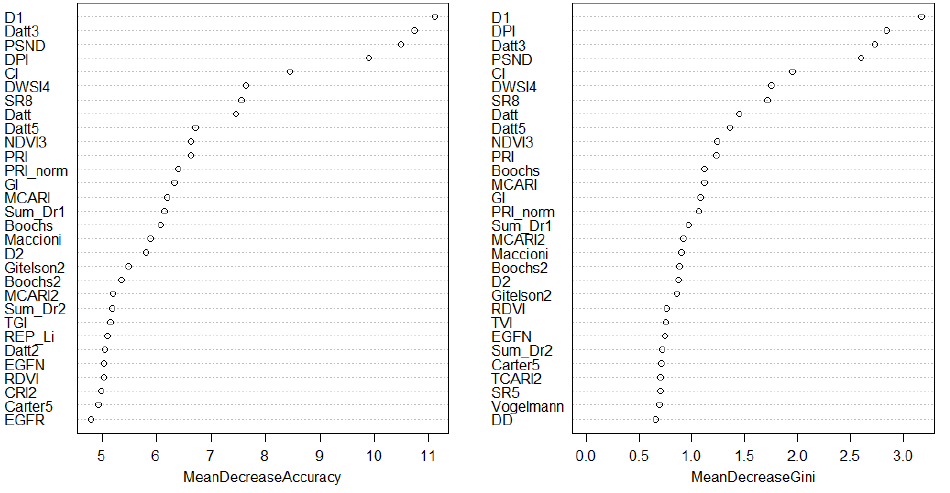
Figure 16. Mean Decrease Accuracy and Mean Decrease Gini. The most significant VIs are D1, Datt3, PSND, and DPI.